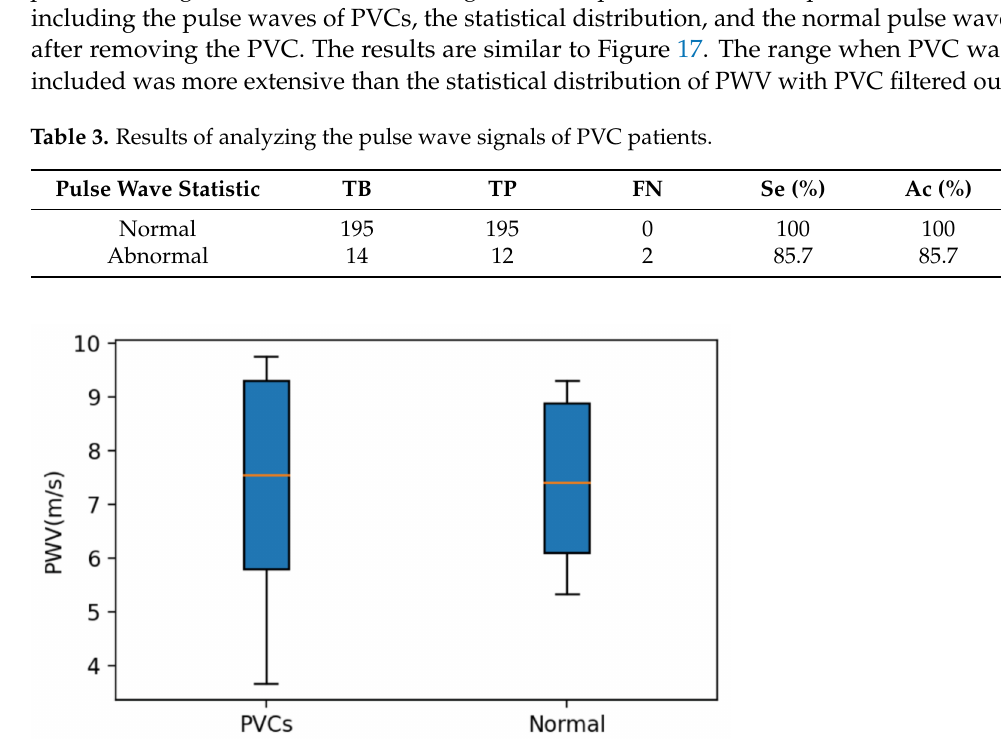
Figure 18. PWVs of PVC and the statistical distribution of the PWV of the normal pulse wave after removing the